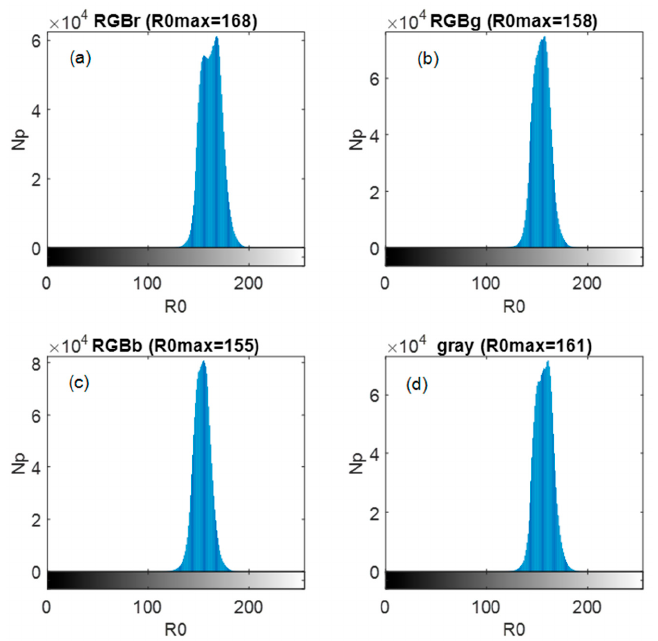
Figure 10. Histograms for blade No. 2 image (1323 K). (Reprinted with permission from Ref. [8]. 2022, AFIT.)